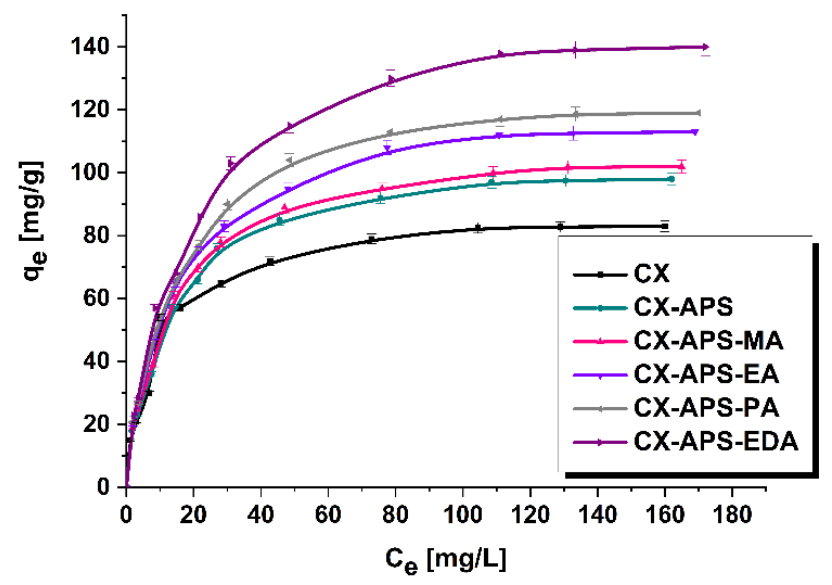
Figure 6. Isotherms of thymol blue adsorption on carbon xerogels (adsorbent mass, 20 mg; initial dye solution concentration, 12.5–150 mg/L; volume of dye solution, 50 mL; pH = 4; temperature, 22 ± 1 °C).